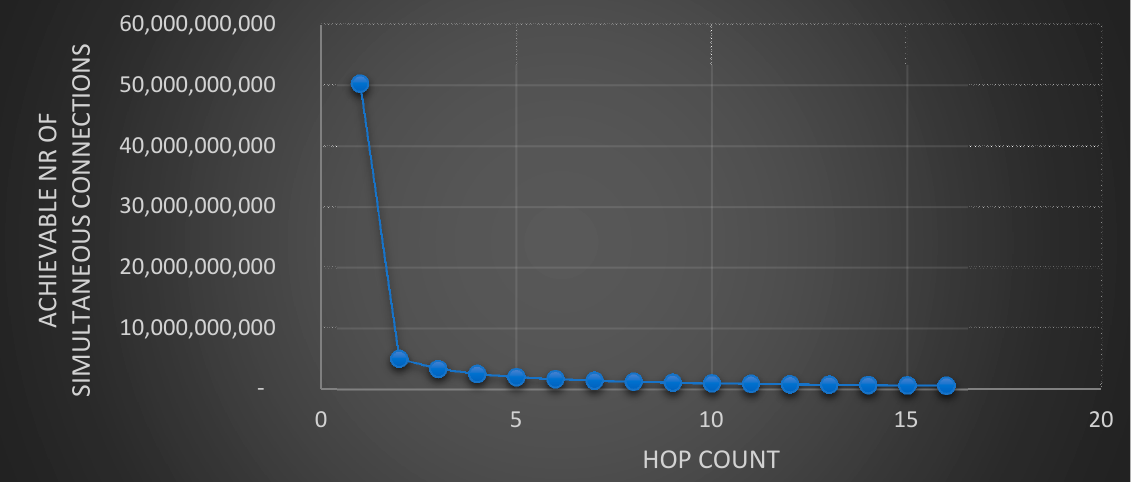
Figure 19. Achievable simultaneous connections based on hop-count. Realistic scenario in which nodes perform a fallback to having transmission tokens attached alongside 1% of data packets.